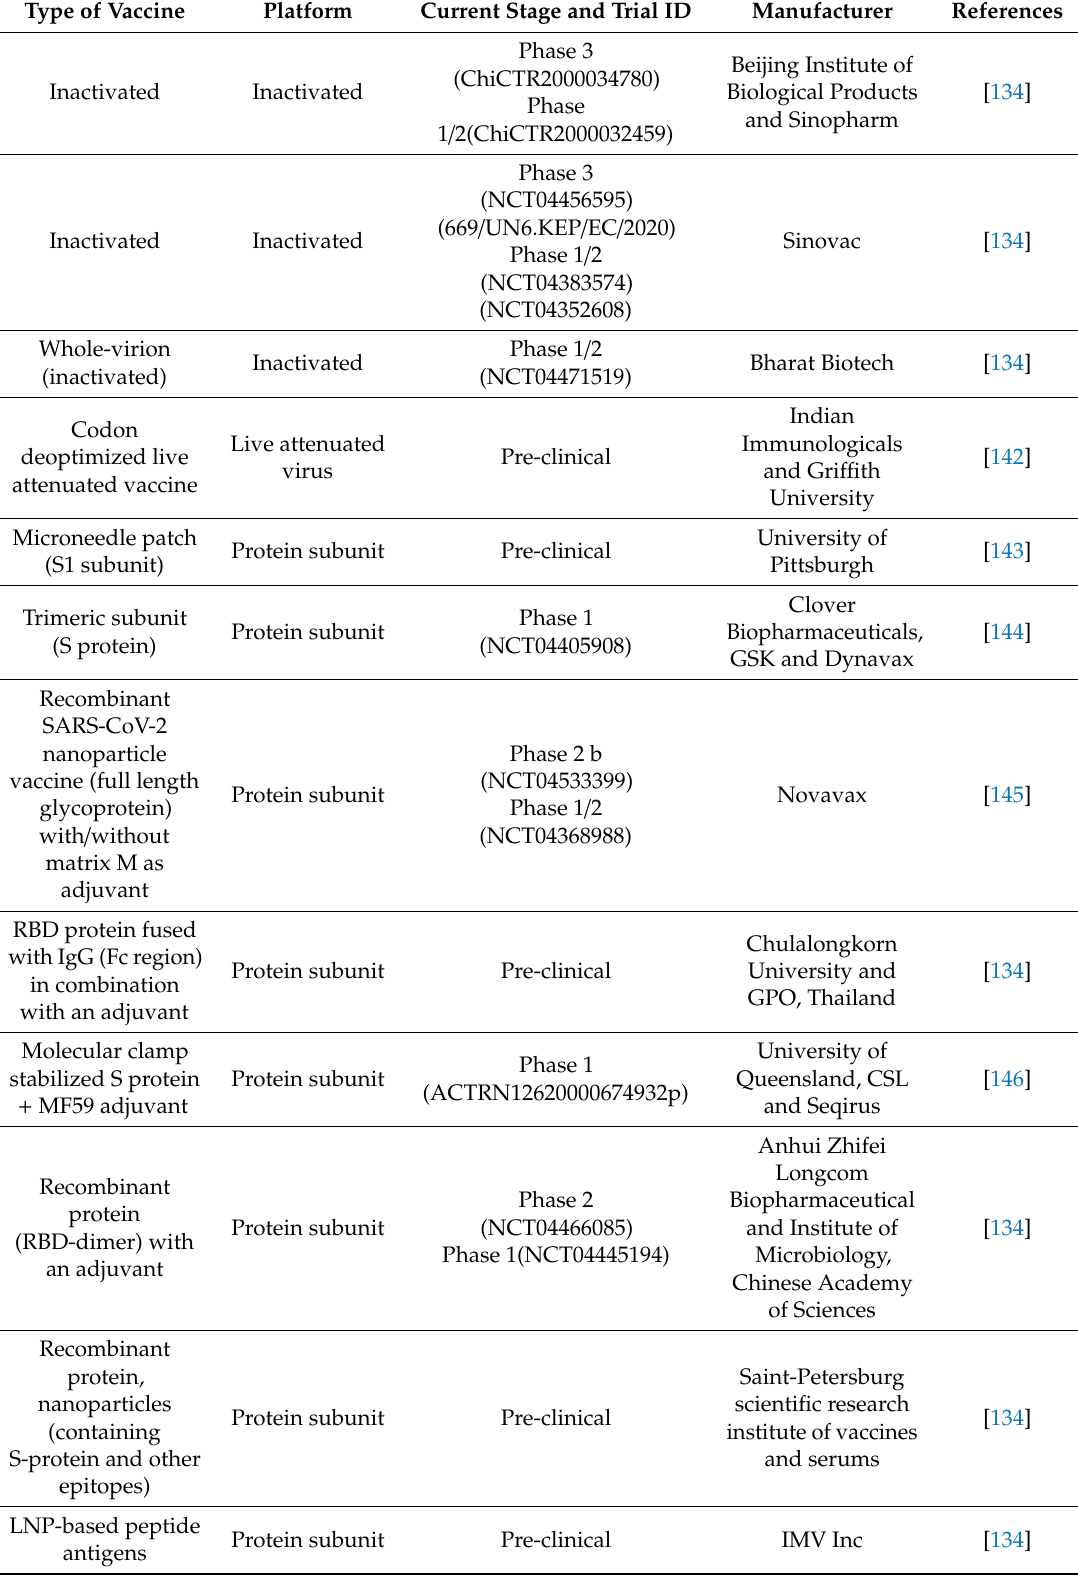
Table 3. Examples of vaccines currently being developed for